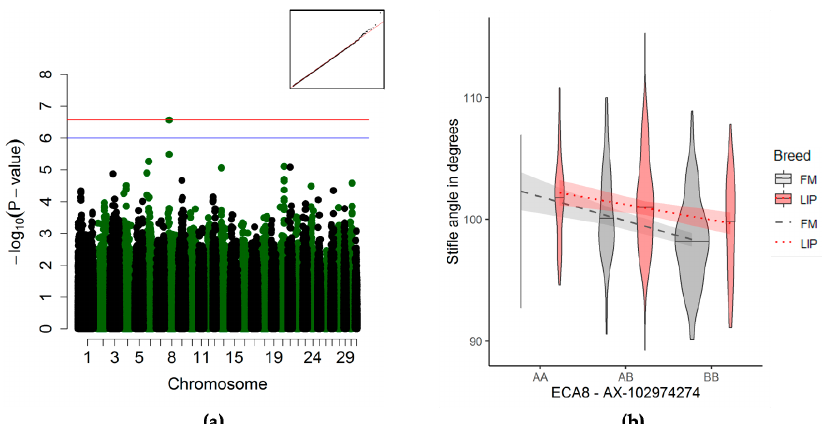
Figure 4. Genome-wide association study (GWAS) for the stifle joint angle ( n = 495). ( a ) Manhattan plot and Q–Q-plot (inset) (blue line) representing the suggestive significance threshold ( p < 10 − 6 ) and (red line) the significance threshold (p Ind < 2.66 × 10 − 7 ). ( b ) Violin plot and trend lines (standard error in translucent) representing the genotype effect of the significant SNP on ECA29 on the elbow joint angle.